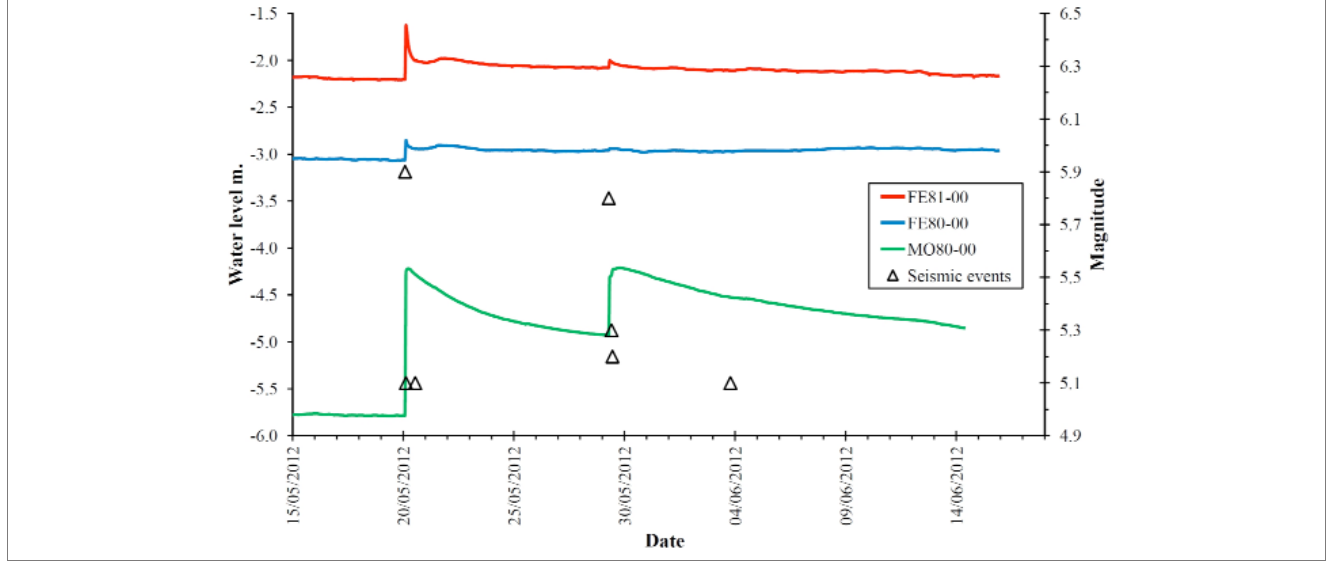
Figure 2. Water-level changes in concomitance with some significant seismic events. The events characterized by 5.1 ≤ M ≤ 5.9 were considered.